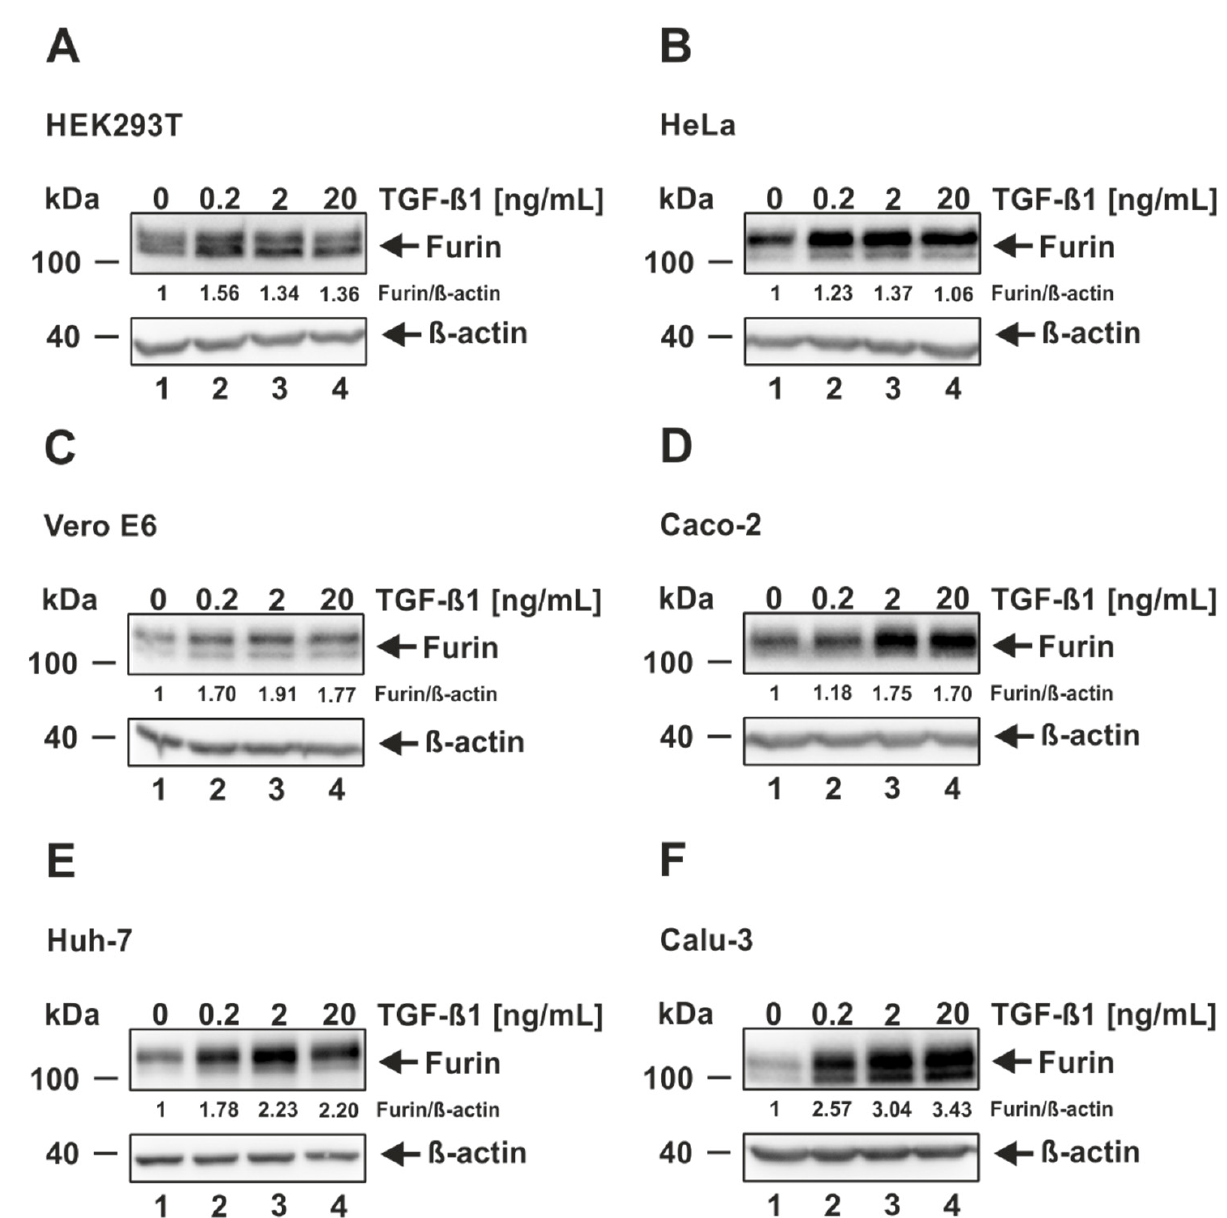
Figure 2. Induction of furin expression by TGF-ß1. ( A ) HEK293T, ( B ) HeLa, ( C ) Vero E6, ( D ) Caco-2, ( E ) Huh-7, and ( F ) Calu-3 were incubated for 18 h with indicated concentrations of TGF-ß1 or the solvent control 4 mM HCl 0.1% bovine serum albumin (0 ng/mL TGF-ß1). Western blot analyses were performed to detect furin and ß-actin. Protein levels of furin and ß-actin were quantified via densitometric analyses utilizing the Image Lab Software. Protein levels without the addition of TGF-ß1 (0 ng/mL) were set to 1.